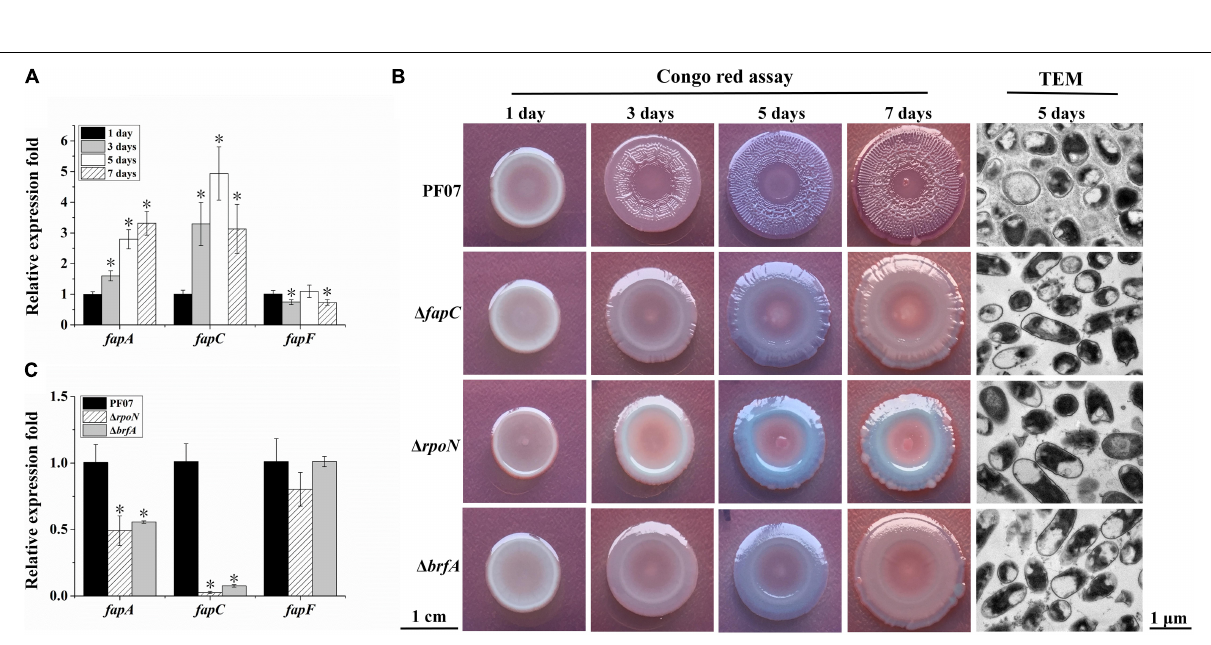
FIGURE 2 | Transcription initiation site and RpoN-dependent promoter of fapA . (A) The 5 (cid:48) -RACE-PCR products of fapA (Lane 1). Lane M, DL2000 DNA marker (Takara, China). (B) The translation start site is indicated by bold and italic text. Nucleotides that were 100% conserved in all examined RpoN-dependent promoters by Barrios et al. (1999) are labeled with asterisks (*). The GG and GC elements are indicated by bold and underlined text.